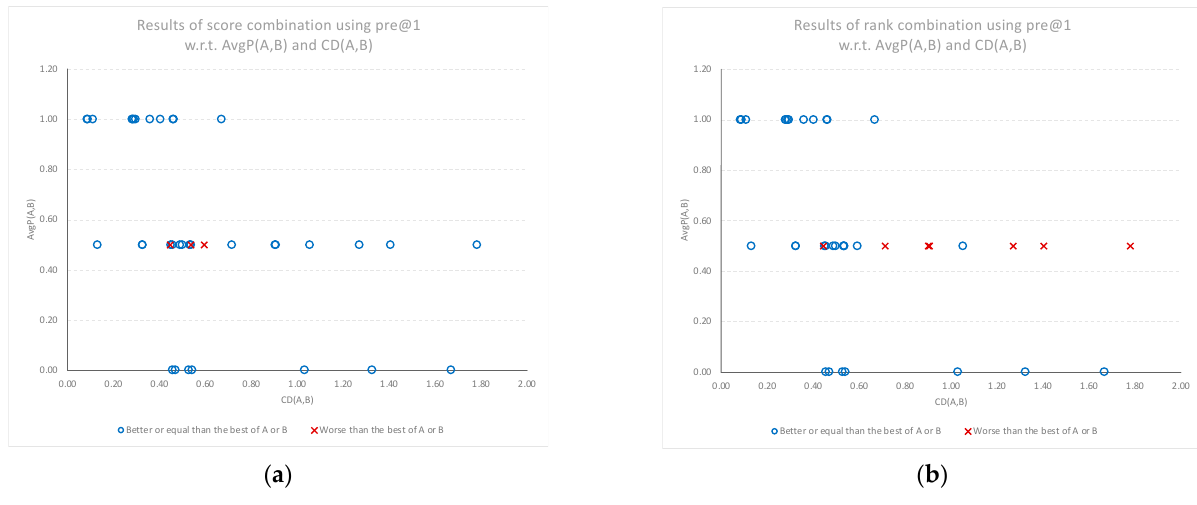
Figure 6. Relative performance of the combined models compared to the best of the individual models (best of A or B) for the top classification, plotted against the average performance (AvgP) of the individual models and cognitive diversity. ( a ) Results when using score combination SC ( A , B ). ( b ) Results when using rank combination RC ( A , B ).